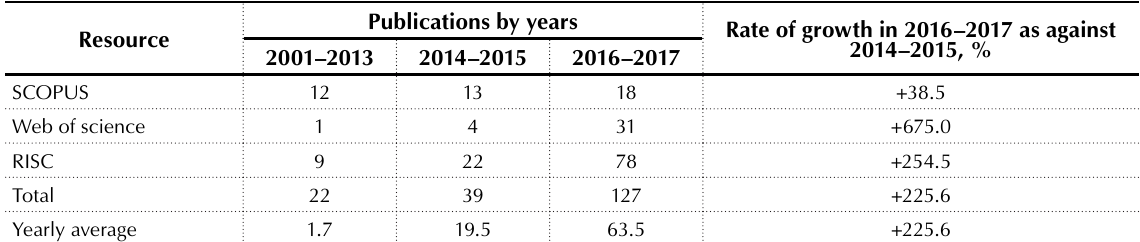
Table 1. Dynamics of number of eSports-related publications for 2001–2017 (for 17 years of the 21st